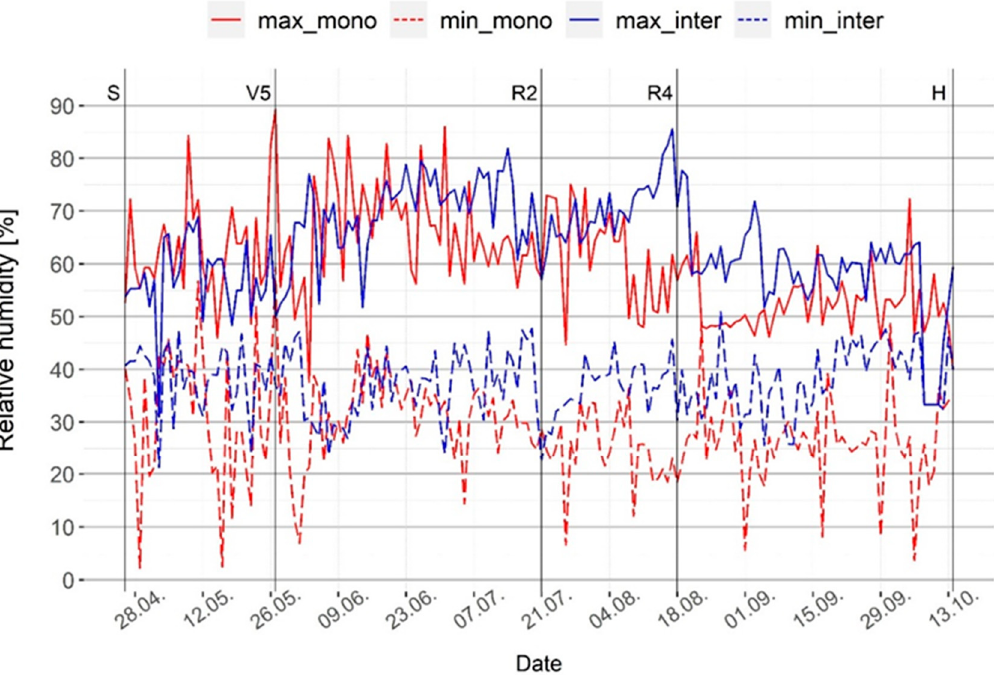
Figure 3. Daily humidity range (minimum and maximum) inside maize rows in the monoculture and intercropped systems. S—maize sowing date; V5—maize five leaves stage; R2—maize blister stage; R4—maize dough stage; H—maize harvest.